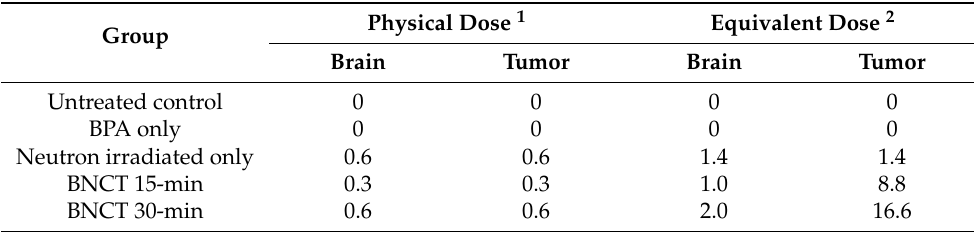
Table 2. Summary of physical radiation doses and equivalent doses delivered in Raji lymphoma bearing mice. Physical Dose 1 Group Brain Tumor Brain Tumor Untreated control